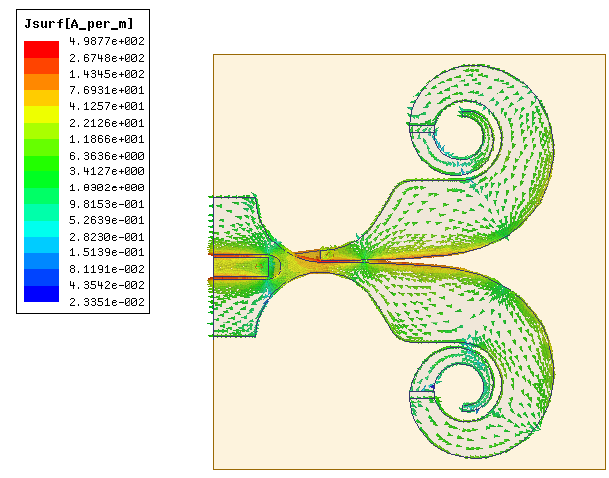
Figure 2. Simulated current distribution on the proposed antenna surface at 5.5 GHz.